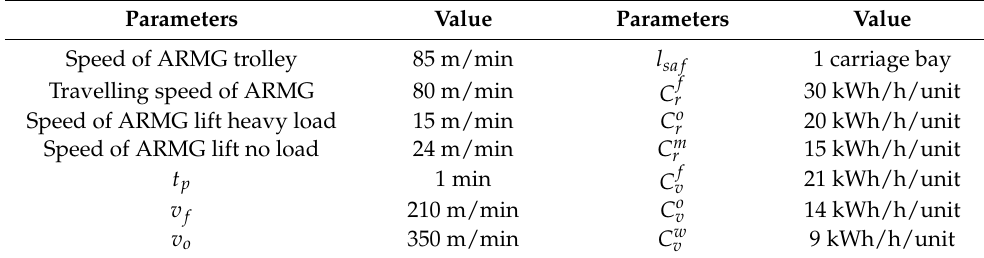
Table 3. Parameters of equipment and models.